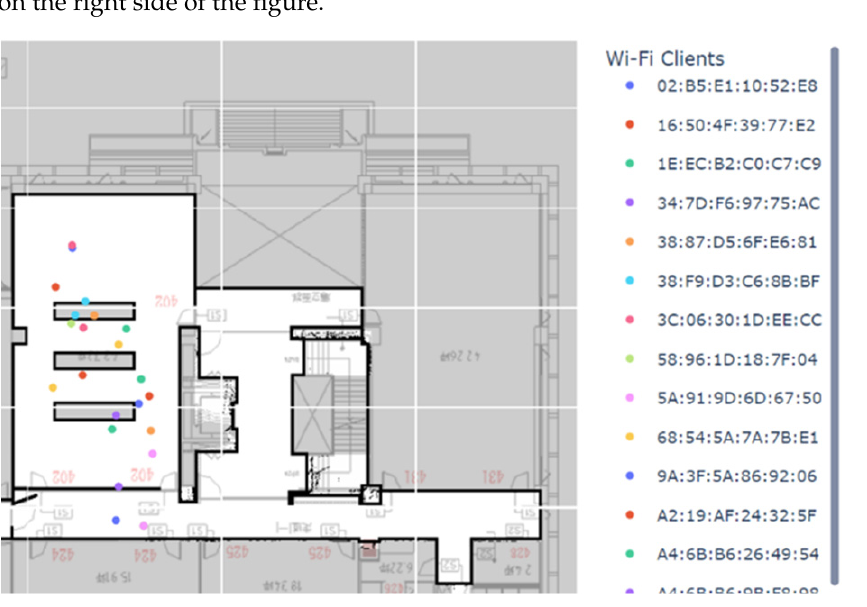
Figure 16. Extraction of DUT’s MAC address in this study.